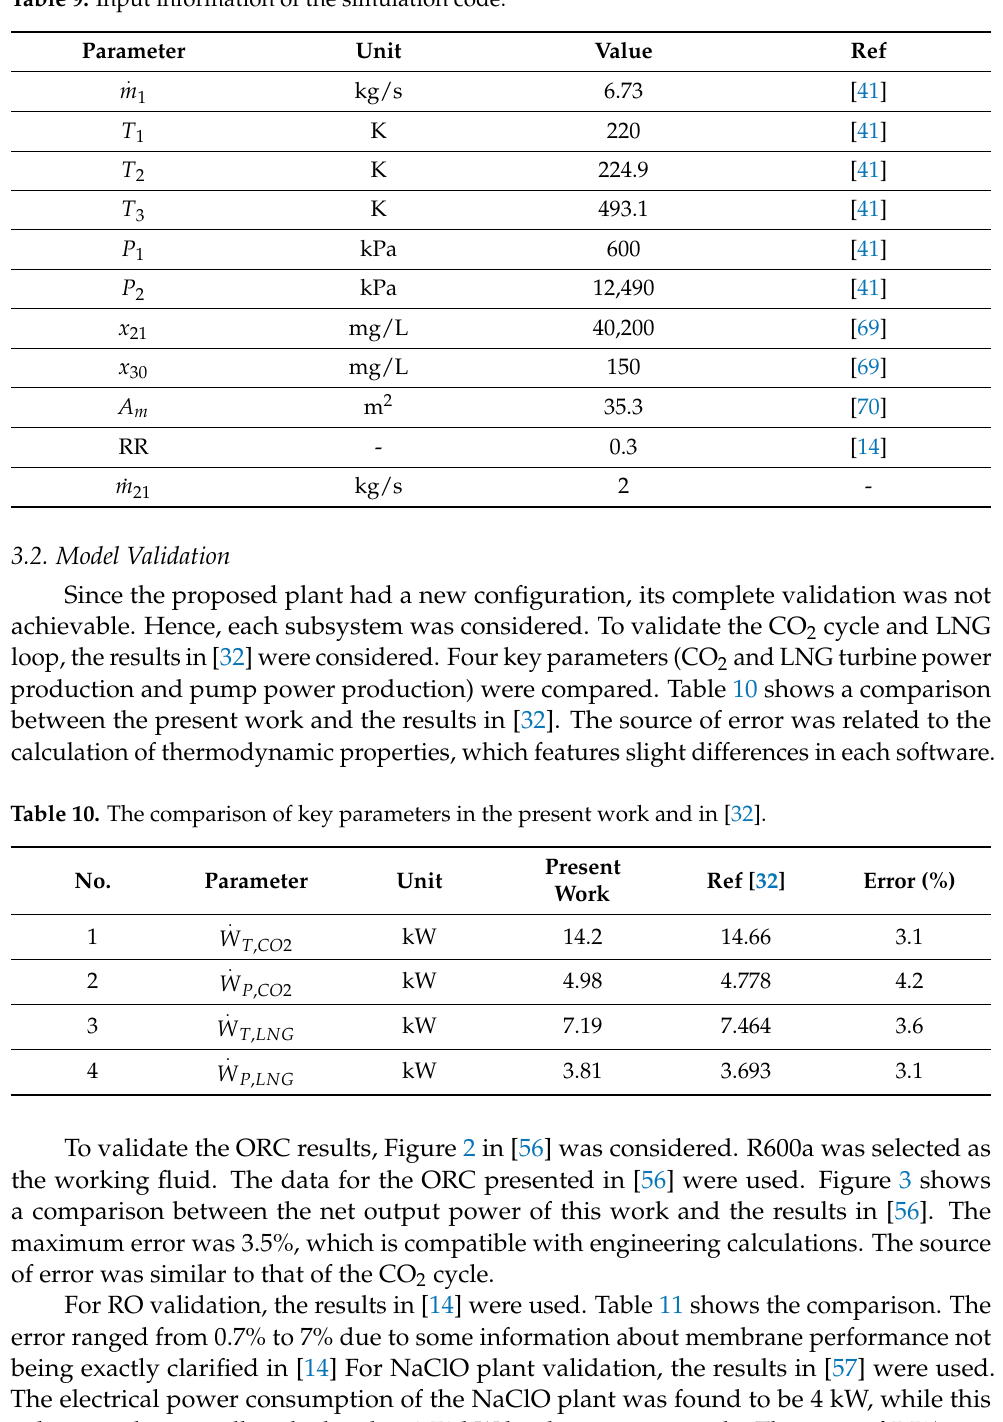
Table 9. Input information of the simulation code.